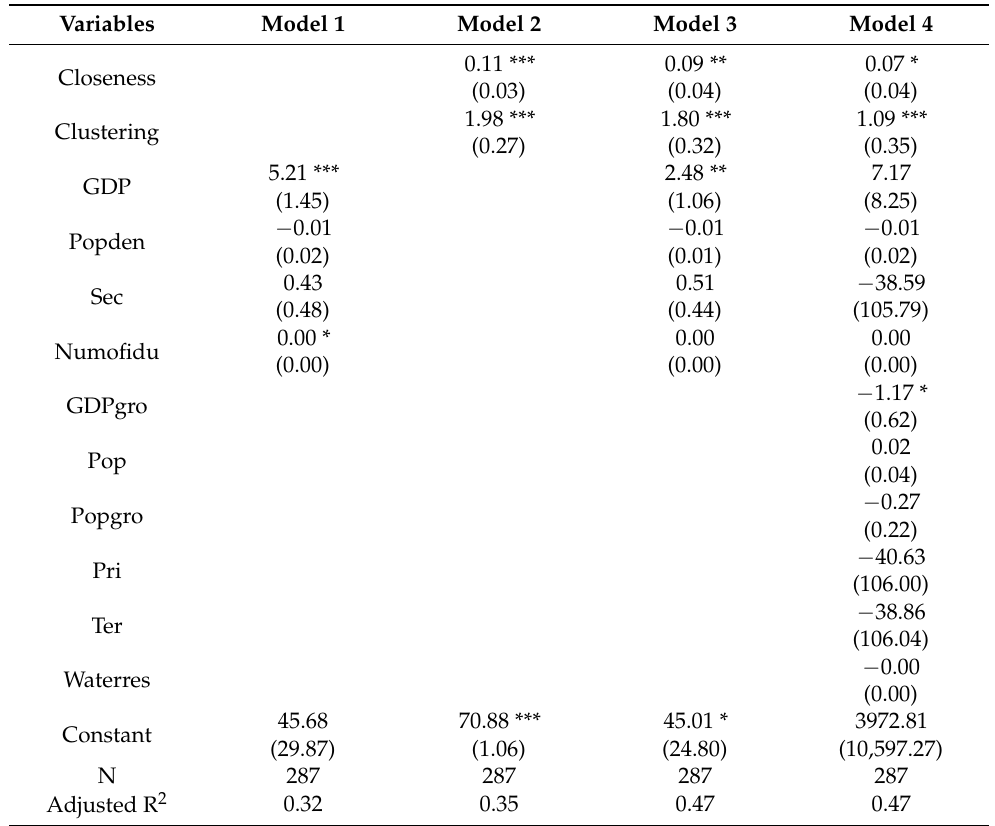
Table 4. Robustness test results for the influence of the local collaboration network on watershed management performance.